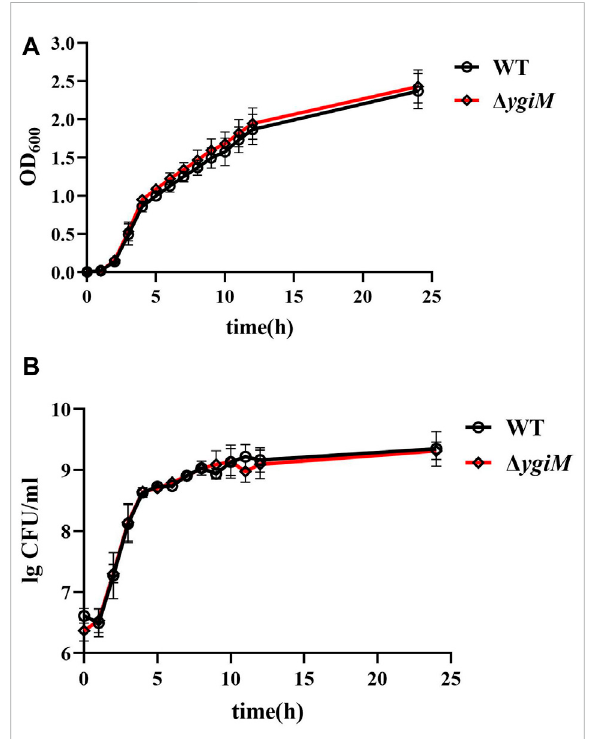
FIGURE 2 Growthcurveandbacterialcolonynumberof K.pneumoniae wild-type strain and ygiM mutant strains. (A) Comparison the growth curves of wild-type and ygiM mutant strains. The experiments were independently repeated three times. (B) Comparison theCFU/mlofwild-type and ygiM mutantstrains.The experiments were independently repeated three